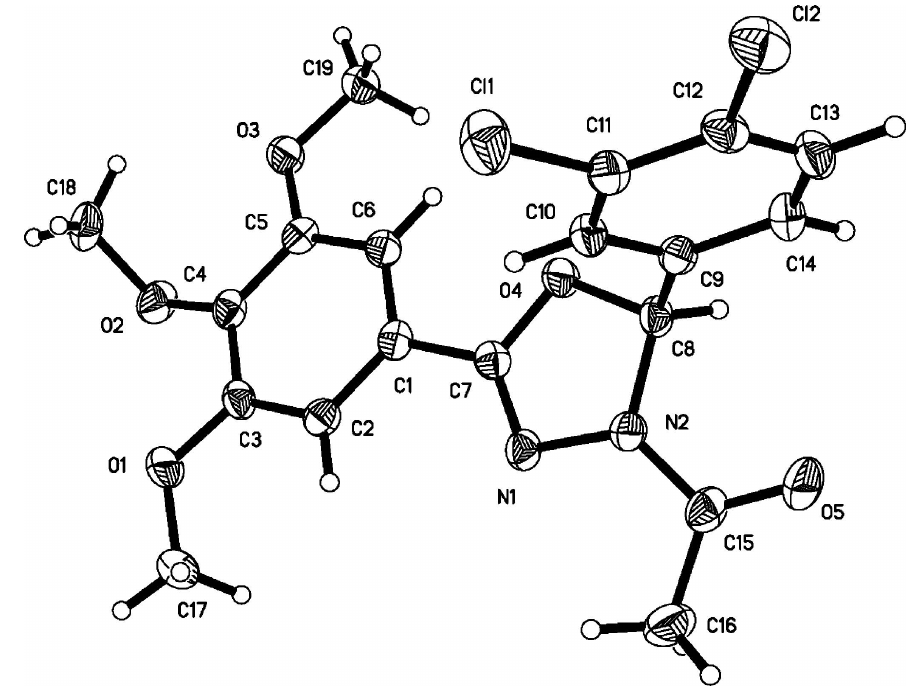
A view of the molecular structure of the title compound, showing the atom-numbering scheme. Displacement ellipsoids are drawn at the 30% probability level. Hydrogen atoms are represented by spheres of arbitrary